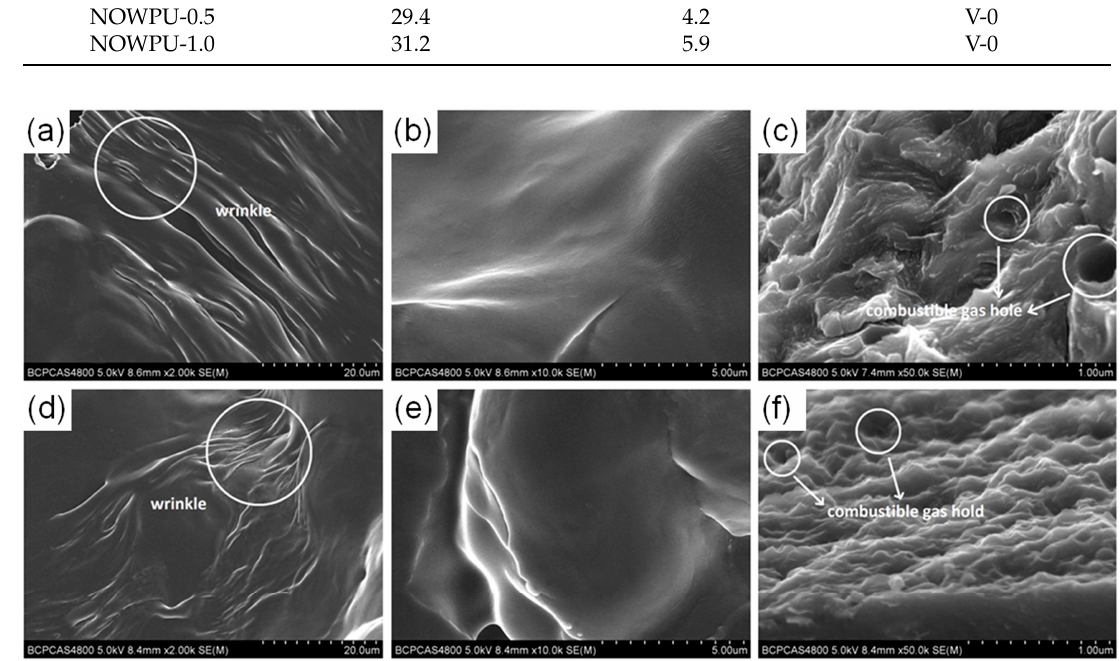
Figure 8. SEM images of ( a ) to ( c ) NOWPU-0.5 and ( d ) to ( f ) NOWPU-1.0.